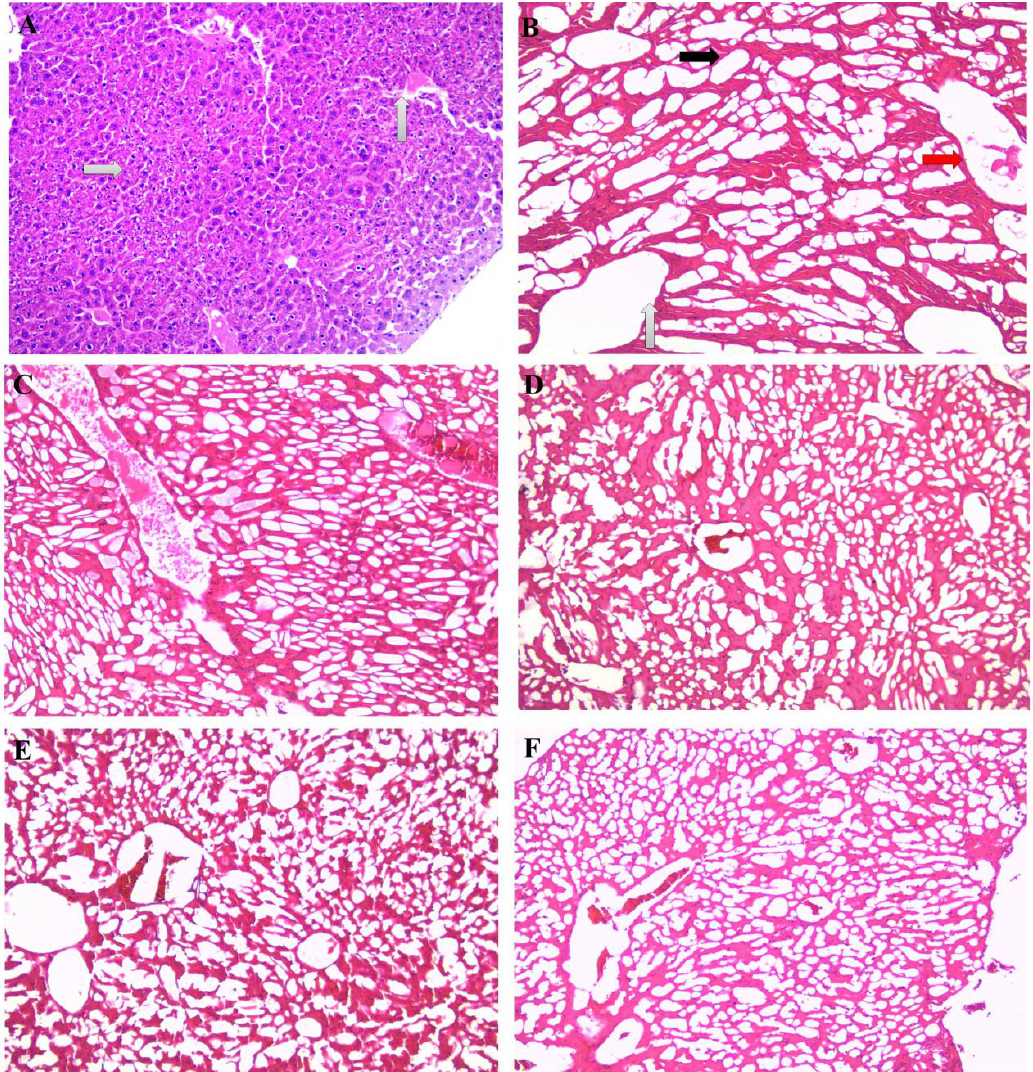
Figure 1. Histopathological analysis of mice liver stained by H&E staining. ( A ) Normal mice liver, ( B ) DEN + CCl 4 -treated mice liver, ( C ) BLE treatment at a low dose of 60 mg/kg of mice b.wt, ( D ) BLE treatment at a high dose of 120 mg/kg of mice b.wt, ( E ) berberine compound at a low dose of 60 mg/kg of mice b.wt, ( F ) berberine compound at a high dose of 120 mg/kg of mice b.wt. Arrows in A indicate the normal hepatocyte phenotype and sinusoid spaces among hepatocytes. In B red arrow indicates the appearance of small tumors along with infiltration of inflammatory cells, black arrow indicates ballooning of hepatocytes and white arrow indicates necrosis in the centrilobular zone. Scalebar 100×.